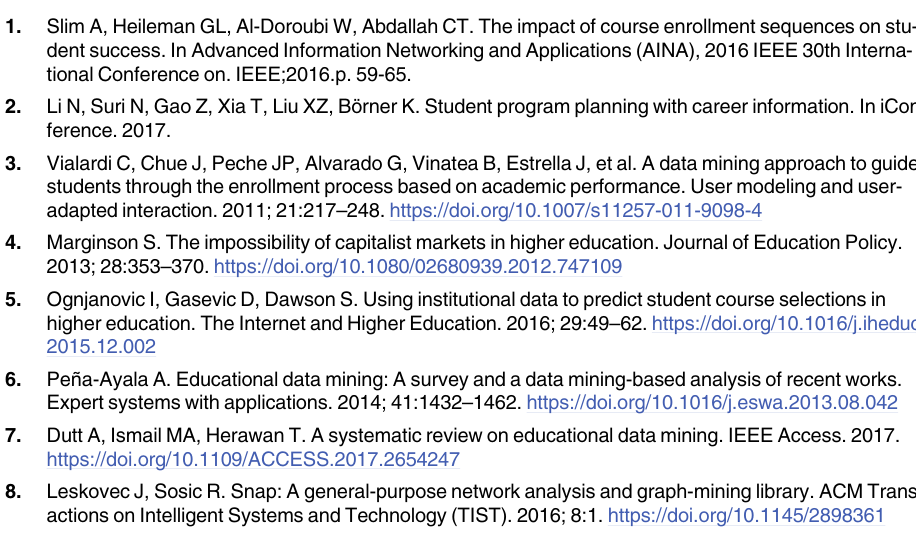
S2 Table. Course statistics of this study. S3 Table. Detailed results for the 25 groups of experiments. S4 Table. FIMs of features from three contrast models on the 10 runs of